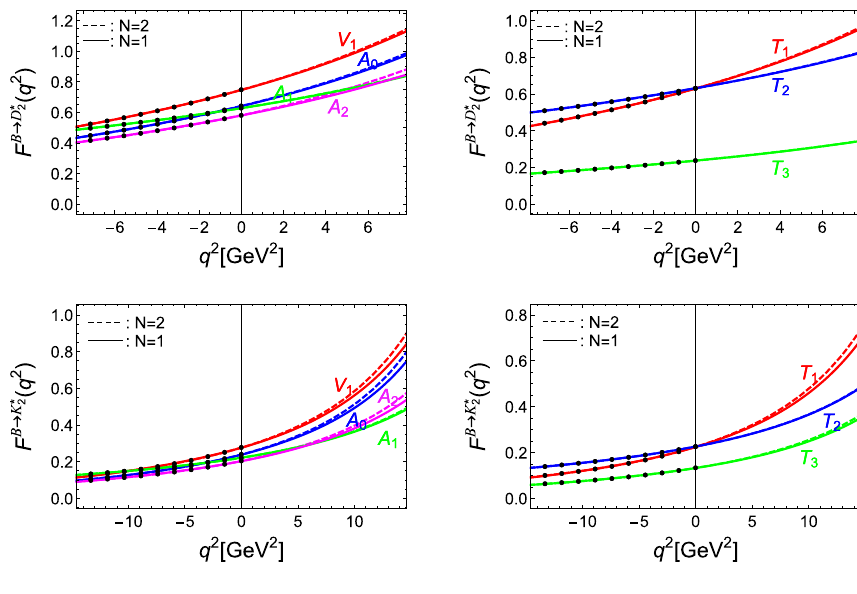
Fig. 7 The q 2 -dependence of form factors of B → D ∗ and 2 B → K ∗ transitions within the 2 truncation-schemes N = 1 and N =